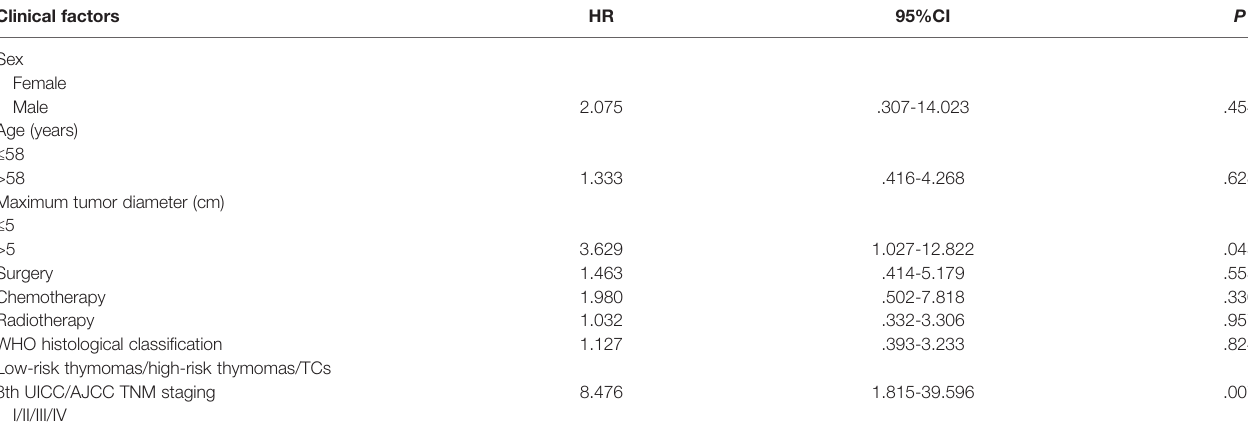
TABLE 4 | Multivariate analyses of overall survival for 84 patients with TETs (II). Clinical factors